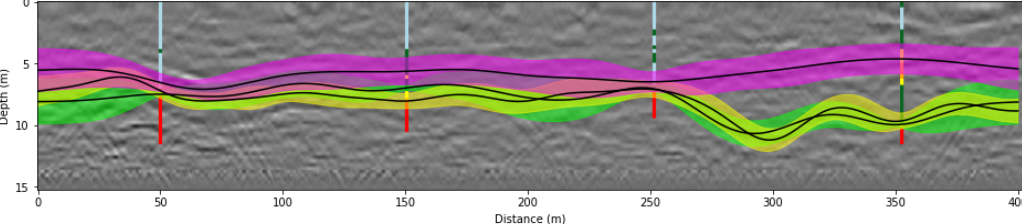
Figure 10. Comparison of different geologist responses on this GPR profile. Note that geologist 3 (purple uncertainty) has an interpretation that is different to those of the other geologists. Specifically, on the right, we can see that geologist 3 mistakenly interpreted the cemented bauxite in the middle of the exploration hole as the geological transition point. This was caught in the auditing process.